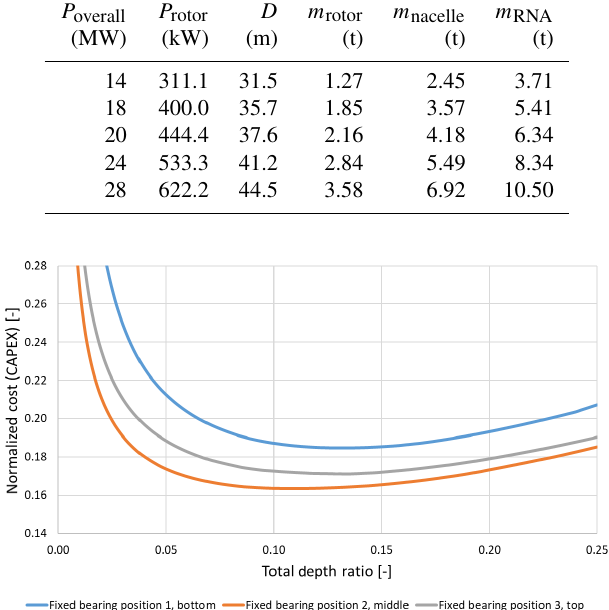
Figure 7. Normalized cost (CAPEX) of the 14MW MD-MRS over design parameter changes.